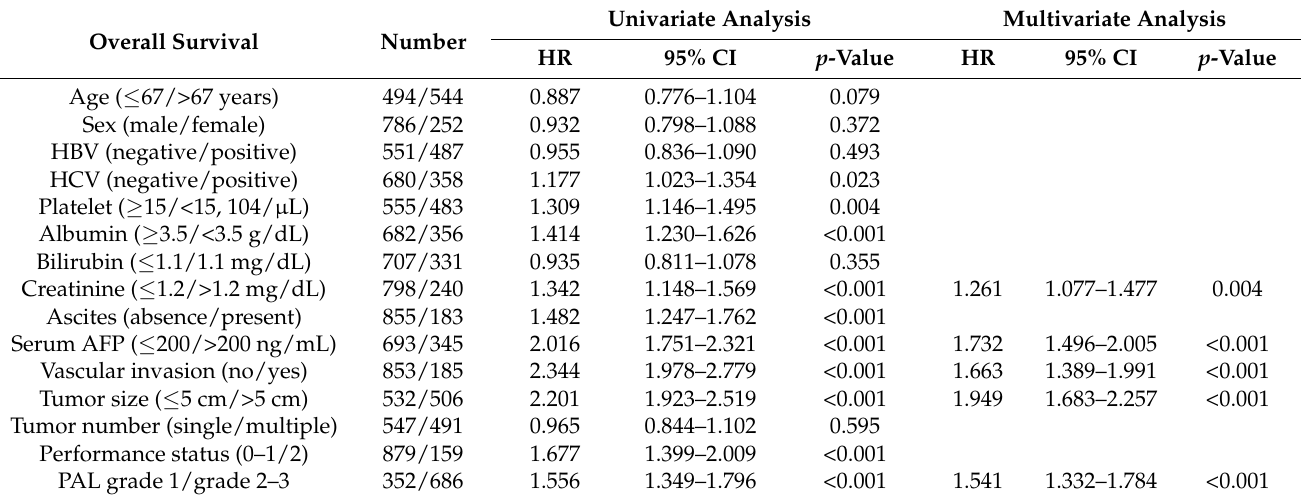
Table 6. Multivariate analysis of overall survival in patients undergoing transarterial chemoemboliza- tion including PAL